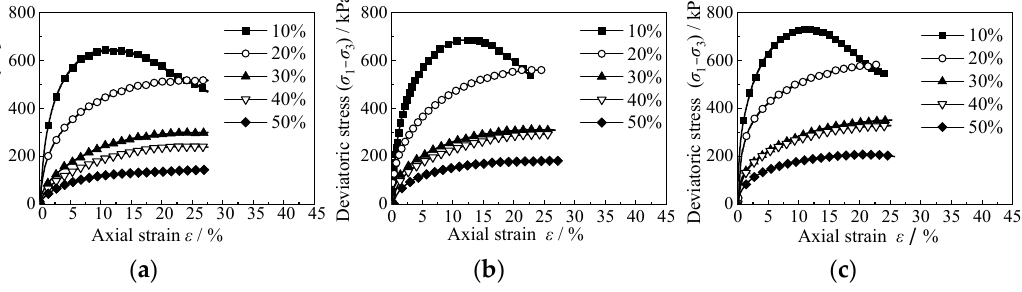
Figure 7. Stress–strain curves of different rubber contents. ( a ) C= 3.5 g/100ml, σ 'm = 50 kPa, ( b ) C = 3.5 g/100ml, σ 'm = 100 kPa, ( c ) C = 3.5 g/100ml, σ 'm = 150kPa.